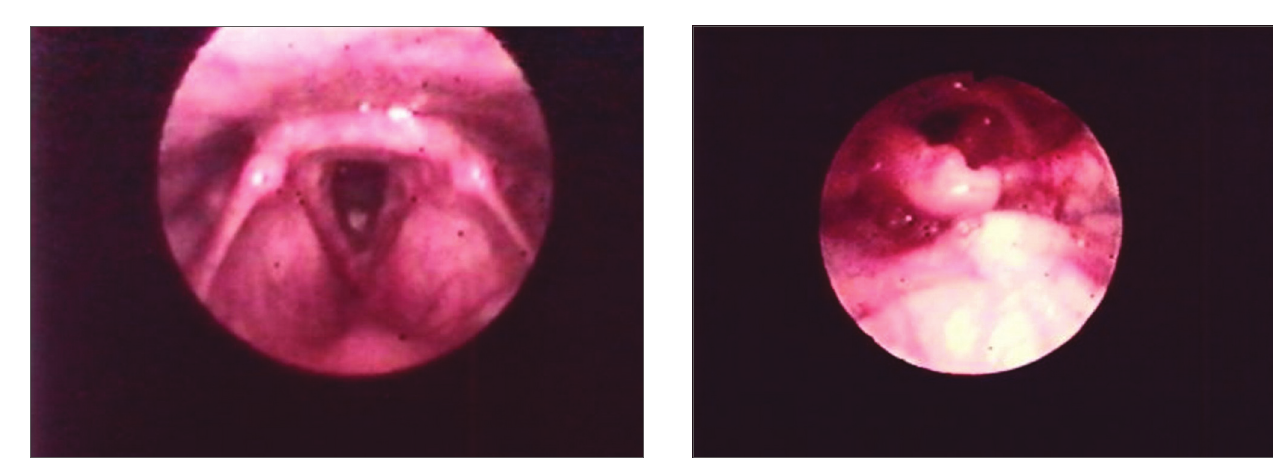
Figura 3. Espessamento de pregas vocais com irregularidade em bordos livres e edema interaritenoide.